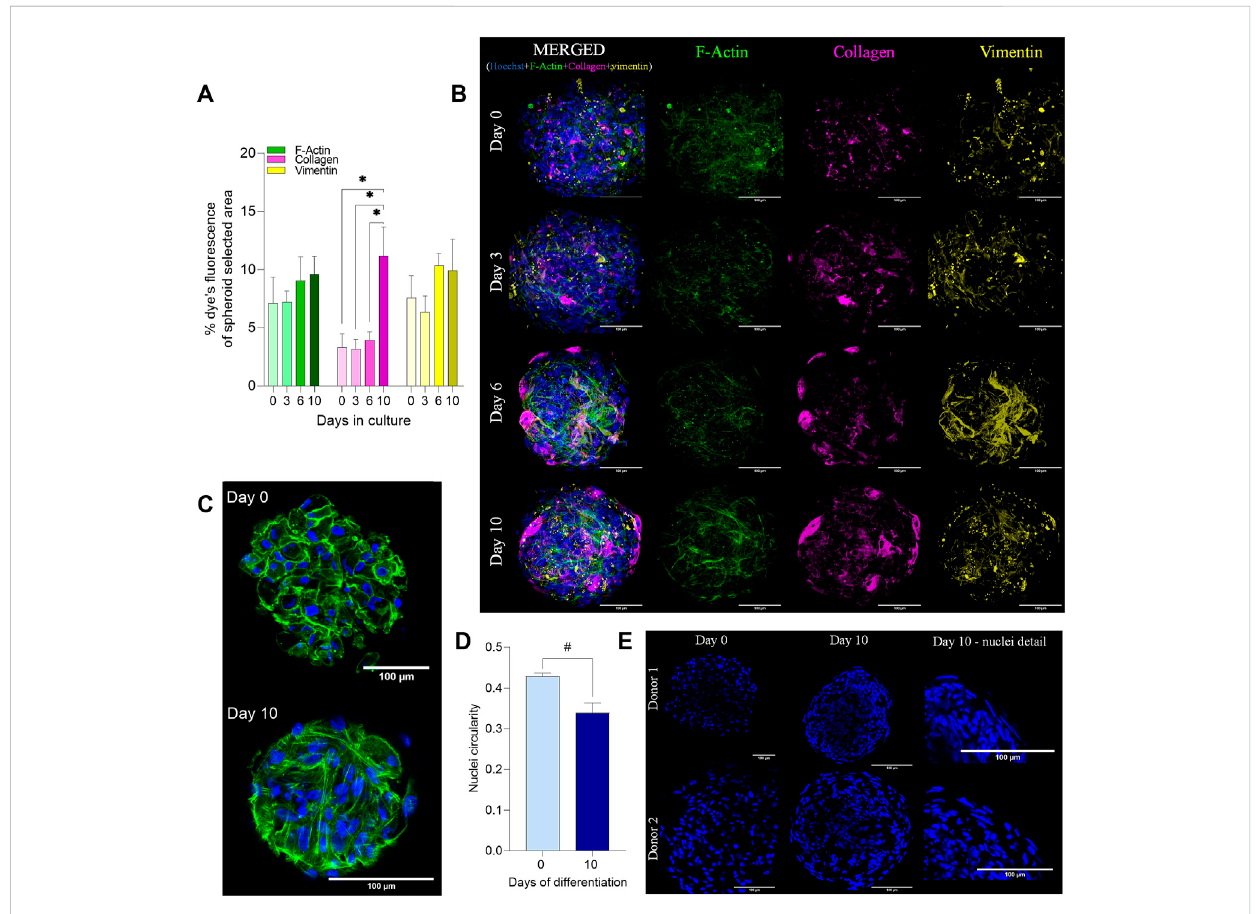
FIGURE 3 Characterization of the internal muscle spheroid structure. Myospheres were formed, differentiated up to 10 days, and fi xed in 4% of paraformaldehyde (PFA) previous staining. (A) Analysis of structural markers represented the percentage (%) of dye in the total spheroid area over culture time. (B) Representative maximum intensity projection of the structural markers: F-actin (green; actin fi laments), collagen (magenta; matrix production), andvimentin(yellow;vimentin fi laments). (C) RepresentativeimageofF-actinbeforeandafterdifferentiation(days0and10)(mergebetweennuclei (blue) and F-actin (green)). (D) Analysis of nuclei circularity (Hoechst) at 0 and 10 days of differentiation. (E) Representative fl uorescence image sections from two different donors of nuclei staining at 0 (single rounded nuclei) and 10 (fused/elongated nuclei) days of differentiation. Scale bar = 100 µm. Results are presented as mean ± SEM. * p < 0.05 by ordinary one-way ANOVA test. # p < 0.05 by unpaired t-test